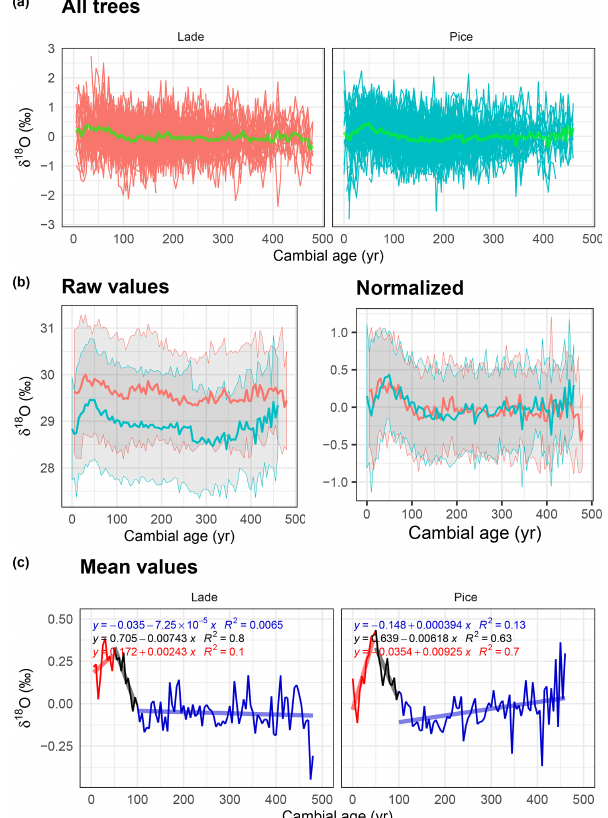
Figure 3. Analysis of δ 13 C data: (a) normalized δ 13 C values of all larch (LADE, red) and cembran pine (PICE, green) trees; the green line corresponds to the mean. (b) Raw (left) and normalized (right) mean value with corresponding ± 1 standard deviation (gray area) of larch (red) and cembran pine (cyan). (c) Plots of the mean values with linear approximations for the periods 1–100 and > 100 years.